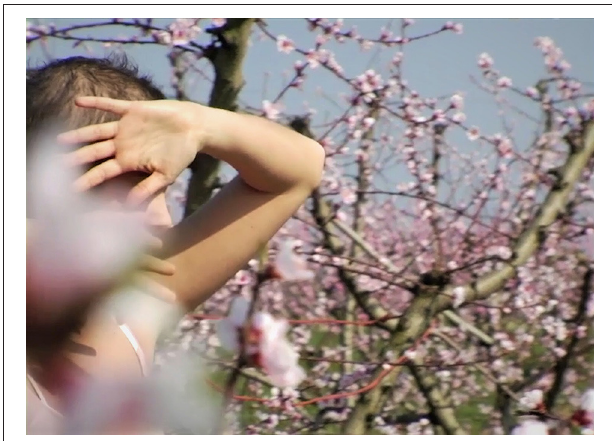
FIGURE 1 | Snapshot from Pini and Pini video article “Resisting the ‘Patient’ Body: A Phenomenological Account” (Pini and Pini,